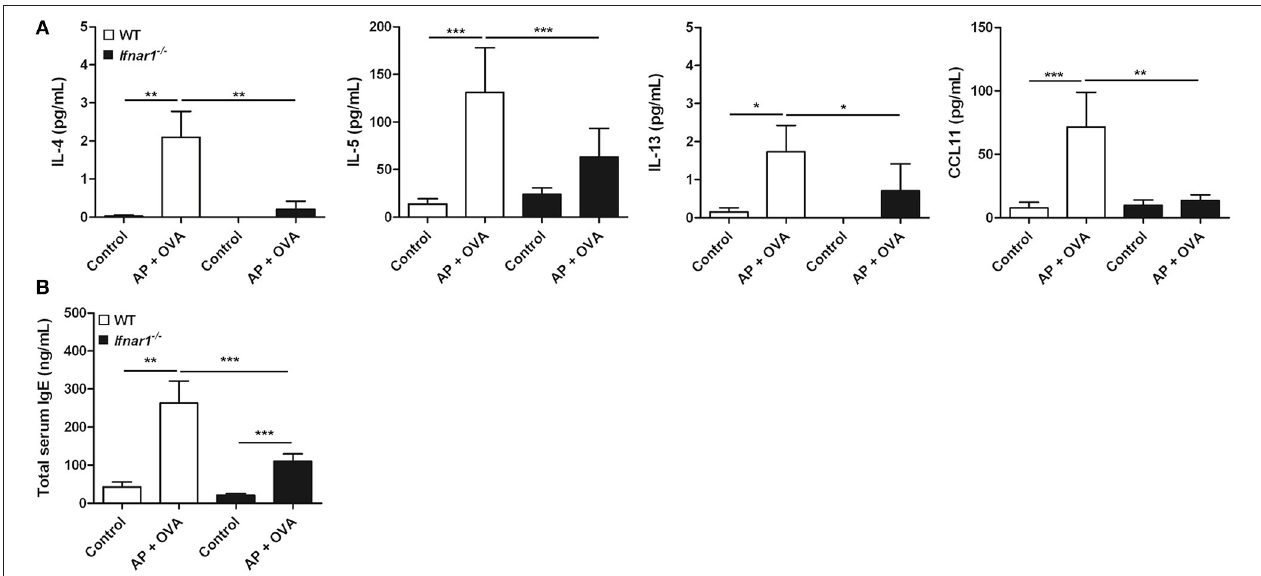
FIGURE 4 | Cytokines in the nasal lavage fluid and total serum IgE levels in the murine model. (A) Production of type 2 cytokines such as IL-4 and IL-5, and the eosinophil chemokine CCL11 induced by Aspergillus oryzae protease (AP) and ovalbumin (OVA) treatment was significantly less in the Ifnar1 − / − AP + OVA challenged mice than in WT AP + OVA challenged mice. (B) Total serum IgE levels were also lower in the Ifnar1 − / − AP + OVA challenged mice than in WT AP + OVA challenged mice. * P < 0.1; ** P < 0.01; *** P < 0.001, repeated measurement ANOVA with Tukey’s multiple comparison